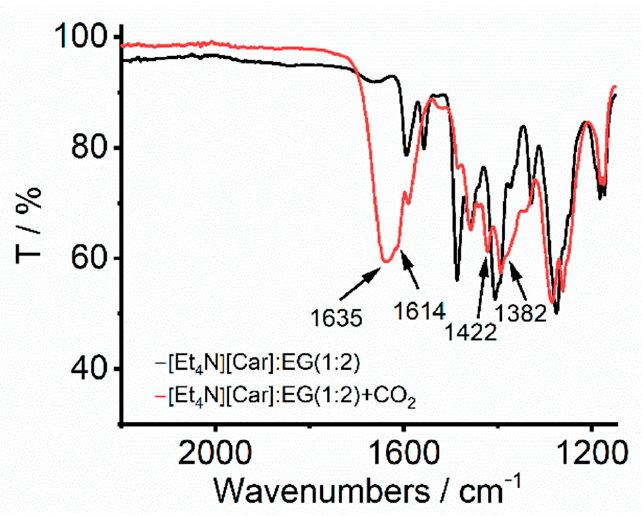
Figure 4. The FTIR spectra of [Et 4 N] [Car]:EG (1:2) before and after CO 2 uptake.